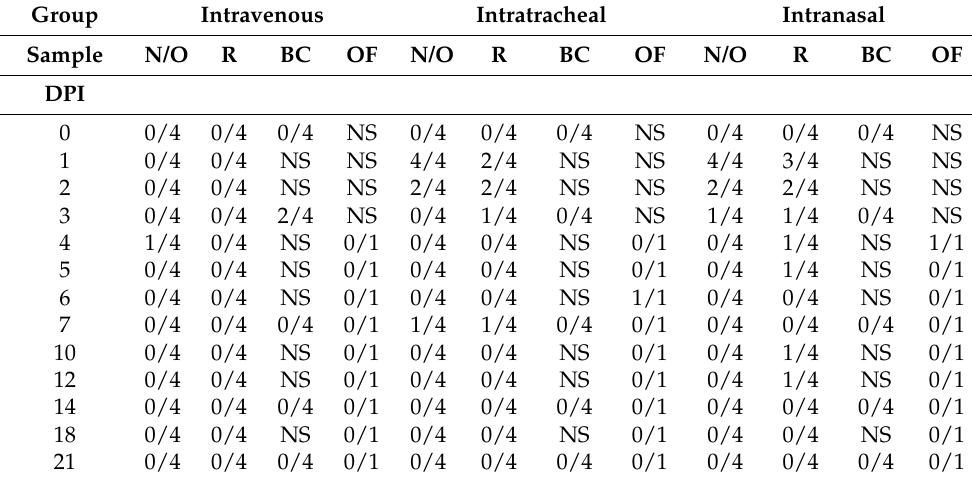
Table 1. Summary of positive sample type and day as determined by